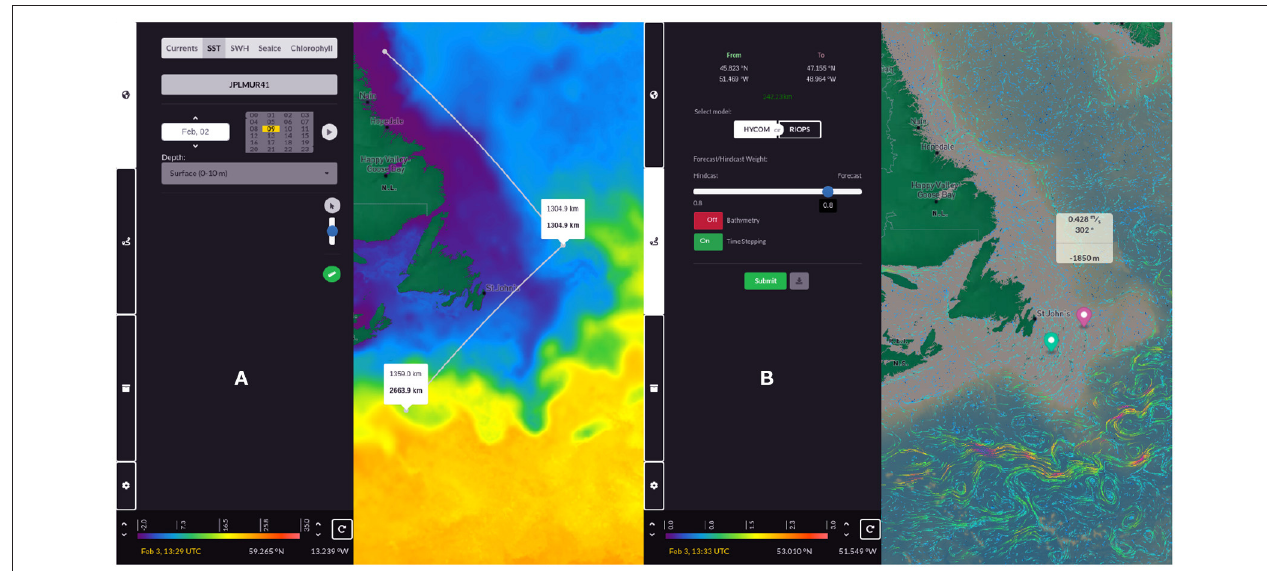
FIGURE 1 | (A) SST layer overlaid by the map distance tool. The left panel shows the user options to change layers, date and time, and depth (if applicable). (B) Screenshot of the cloud-based service v.2.1 showing bathymetry overlaid by the HYCOM model layer. The route–planning panel is shown to the right with user choices such as bathymetry integration.